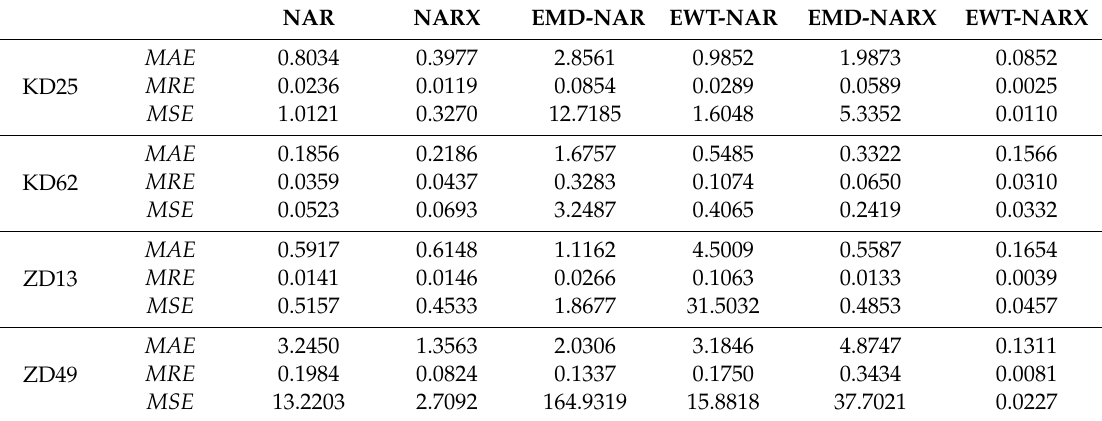
Table 1. The reduction ratio of each model compared to EWT-NARX.